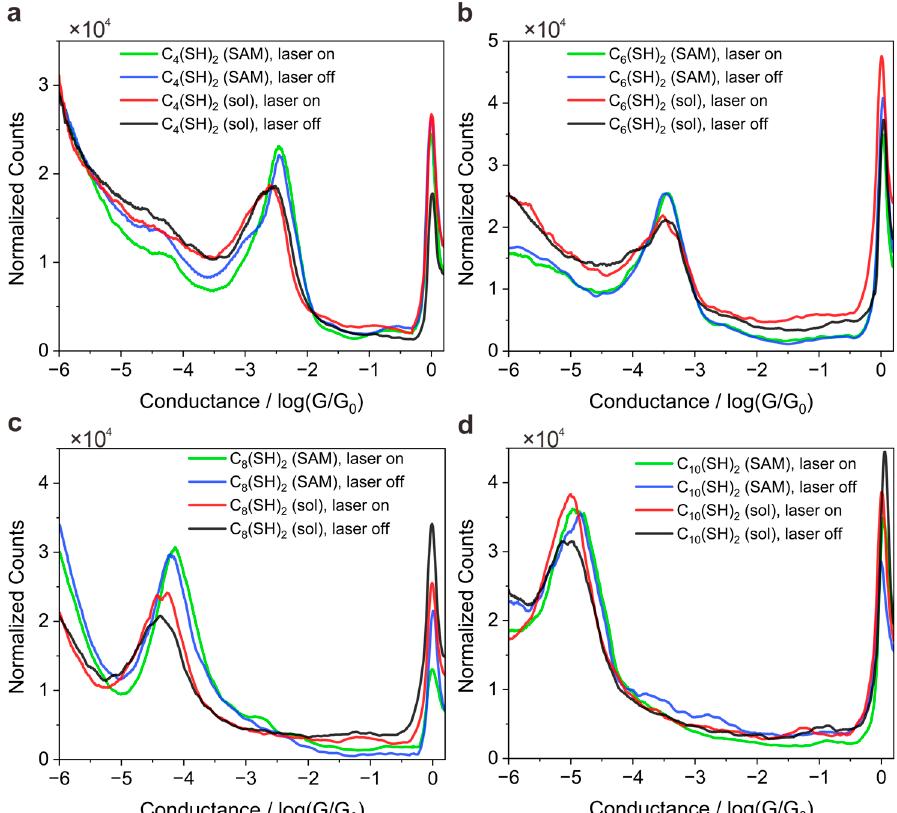
Figure 2. 1D conductance histograms for C n (SH) 2 -based single-molecule junctions that comprise even n numbers. ( a ) 1D conductance histograms of C 4 (SH) 2 with laser switching on or off in SAMs or in solutions. ( b ) 1D conductance histograms of C 6 (SH) 2 with laser switching on or off in SAMs or in solutions. ( c ) 1D conductance histograms of C 8 (SH) 2 with laser switching on or off in SAMs or in solutions. ( d ) 1D conductance histograms of C 10 (SH) 2 with laser switching on or off in SAMs forms or in solutions. G is the conductance, equal to current/voltage. Conductance quantum G 0 = (cid:2870)(cid:3032) 77.3 μS , where e is the electron charge and h is Planck’s constant.